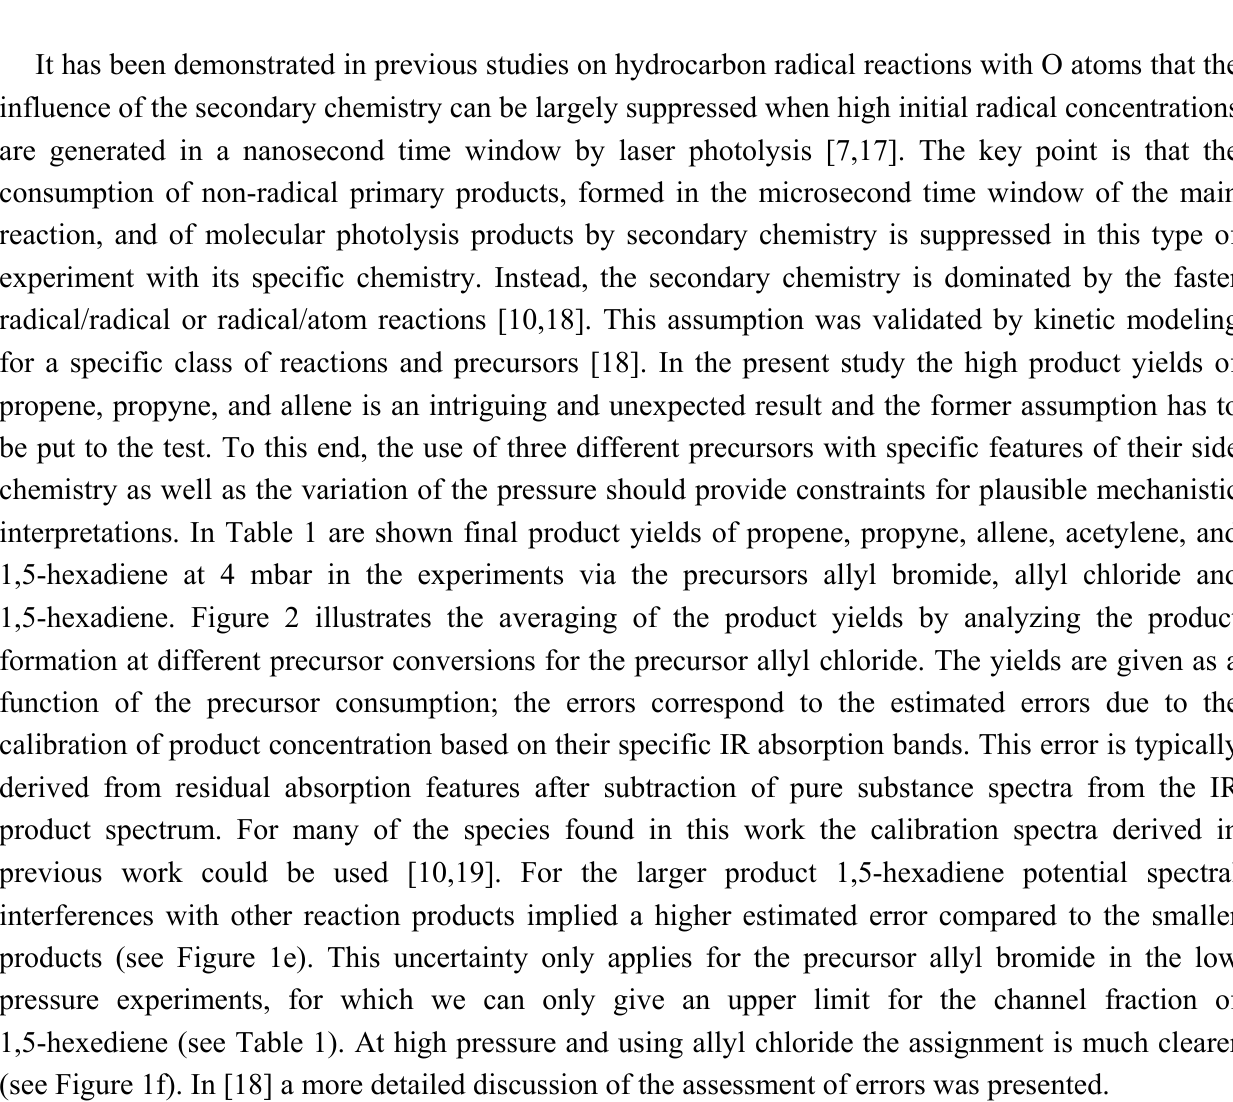
Table 1. Experimentally determined final product yields relative to precursor consumption H + C H reaction for different precursors. p(C for the C 3 5 3 5